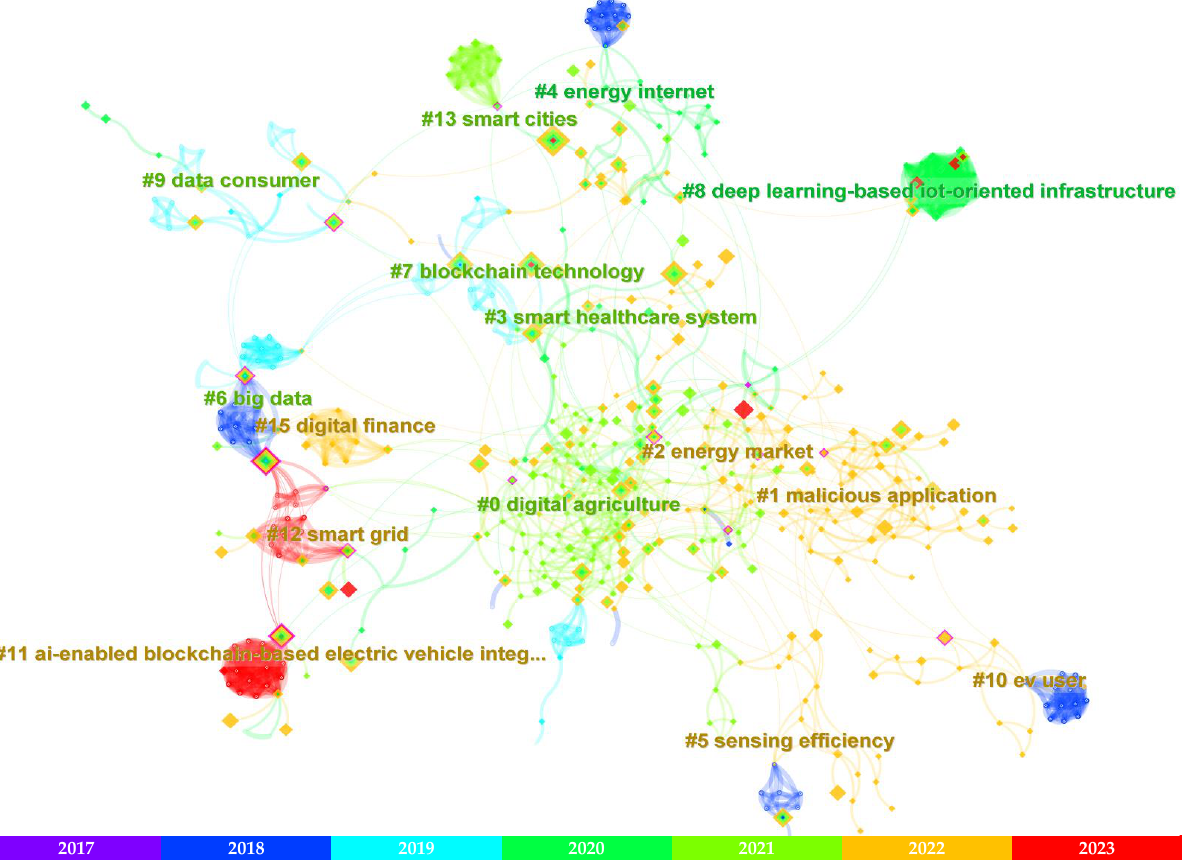
Figure 11. Largest terms’ co-occurrence clusters in the subject field. Cluster #0 on digital agriculture is the largest with 105 nodes and a silhouette score of 0.823. The nodes with the highest frequency (88) and centrality (0.30) are artificial intel- ligence in cluster #6 and adaptive service level agreement in cluster #2. The most recent bursting term in this field is smart factories in cluster #2 (focused on the energy market), which started bursting in 2022 with a strength of 2.28 and a sigma of 1.00. Smart factories is connected to the Industrial Internet, which in turn is connected to the IoT system and data management in the network. 3.5. Intellectual Perspective of the Study Area 3.5.1. Author Co-Citation Network An author co-citation network is utilized to identify areas of expertise that are widely recognized by research communities in the field of AI – blockchain in smart cities. Co-cita- tion occurs when two references are cited by a third reference. The articles retrieved from WoS in this field cite 25,963 publications with one or more authors, as shown in Table 1. To perform this analysis, CiteSpace parameters are set to k = 25, LRF = – 1, LBY = – 1, and e = 1. The merged network is pruned using a pathfinder algorithm, resulting in a network of 453 nodes and 1192 links. A node’s size represents the number of citations an author has received, while the thickness of the link between two nodes indicates how many times two authors have been cited together in the same articles. A network density of 0.012 in- dicates that strong co-citation relationships have yet to be formed in this field.